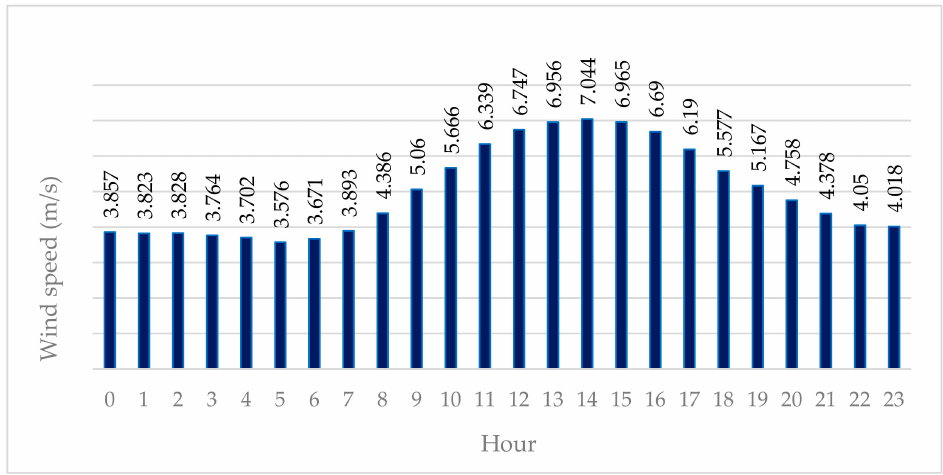
Figure 7. Distribution of the wind speed per hour of the